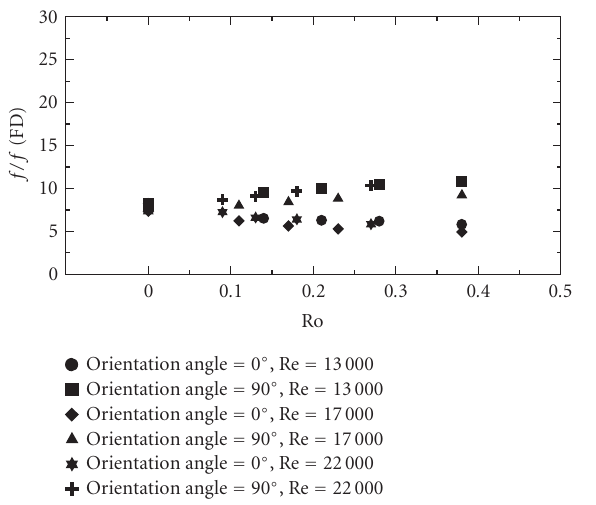
Figure 11: Variation of the friction factor ratio for 45 ◦ ribbed radial outward flow channel for a rib pitch-to-height ratio of 10.